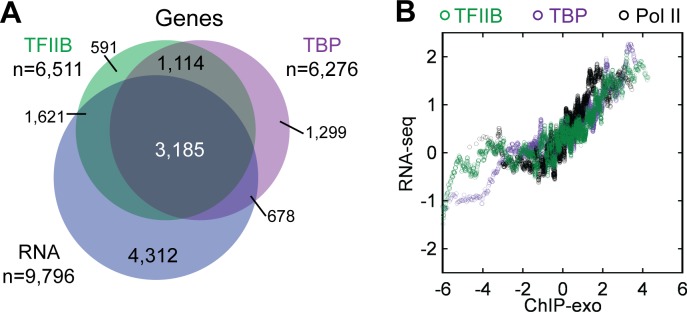
Overlap and trend of ChIP-exo data at mRNA genes.(A) Venn overlap among mRNA genes having TBP or TFIIB locations (<500 bp from its TSS) and genes with measured polyadenylated mRNA levels detected by RNA-seq [39]. Data thresholding may contribute to nonoverlapping sets. (B) Moving average (100-gene) of mRNA levels versus TFIIB/TBP/Pol II occupancy levels on a median-centered log2 scale.